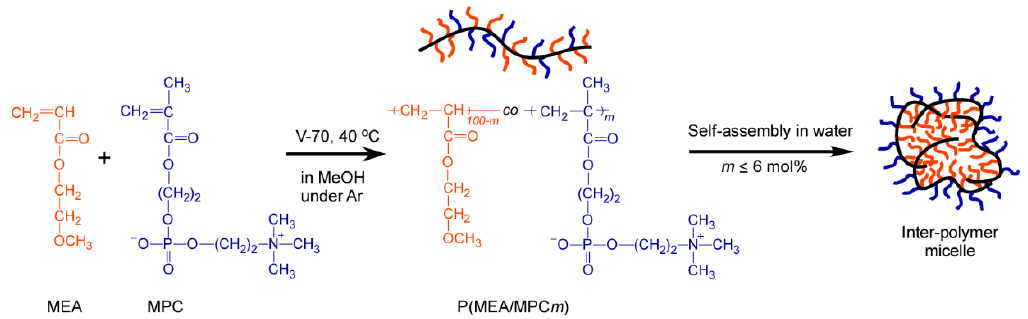
Figure 1. Synthesis and conceptual illustration of the self-assembly processes of the statistical copolymer, P(MEA/MPC m ), in water.